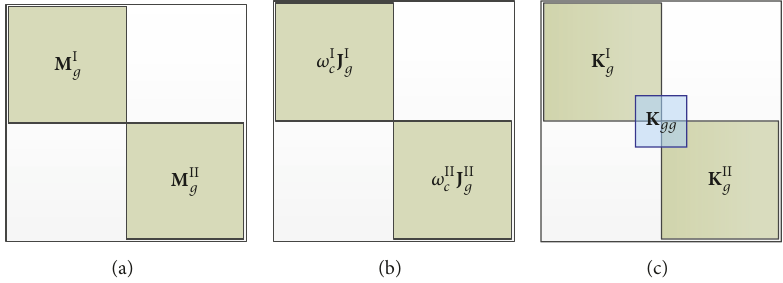
Figure 5: Assembly of the two-stage planetary gear system matrices: (a) the mass matrix, (b) the gyroscopic matrix, and (c) the stiffness